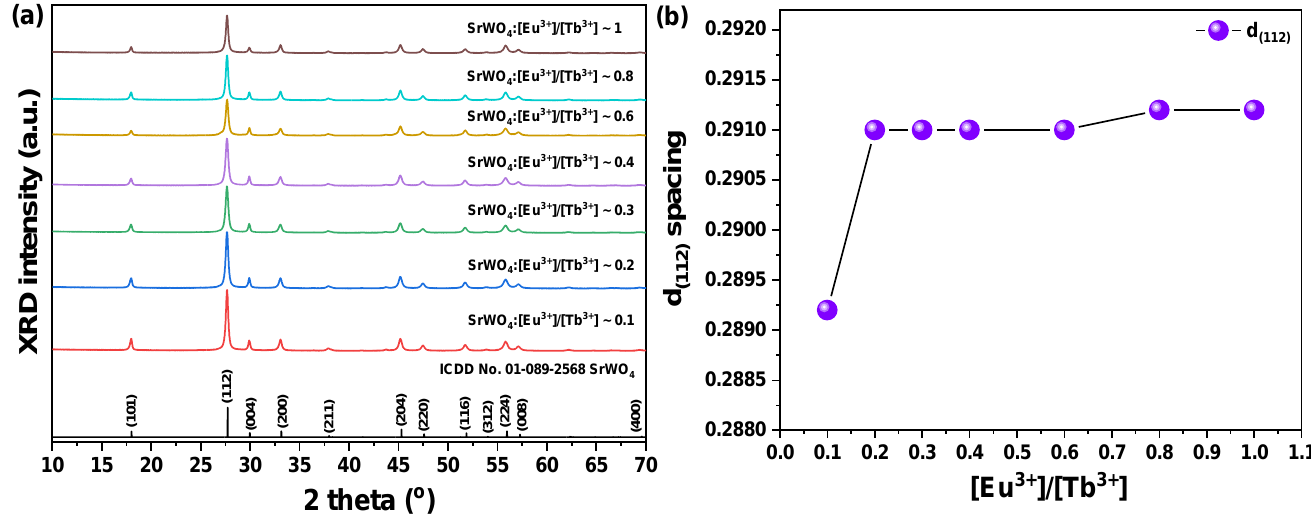
Figure 5. ( a ) XRD patterns of SrWO 4 :[Eu 3+ ]/[Tb 3+ ] and ( b ) change of d (112) spacing.